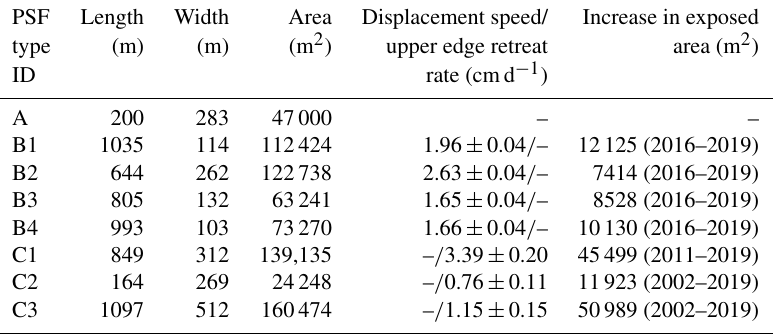
Table 2. Dimensions of PSFs in the study area. We selected periods of high-resolution images with the most obvious terrain changes, the PlanetScope image (2019) for type A, the UAV images (2016–2019, Fig. S1) for type B, and the PlanetScope, RapidEye, and Google Earth images (2002, 2011, 2014, 2015, 2019) for type C (locations are shown in Fig. 5a). PSF Length Width Area Displacement speed/ Increase in exposed type (m) (m) (m 2 ) upper edge retreat area (m 2 ) ID rate (cmd − 1 ) A 200 283 47000 – –